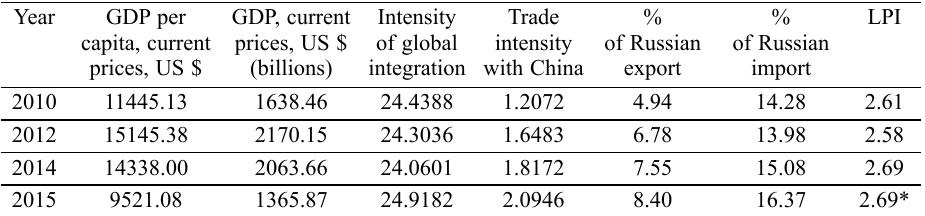
Table 6. Evaluation of the potential of Russia as a participant of the NSR Year GDP per capita,